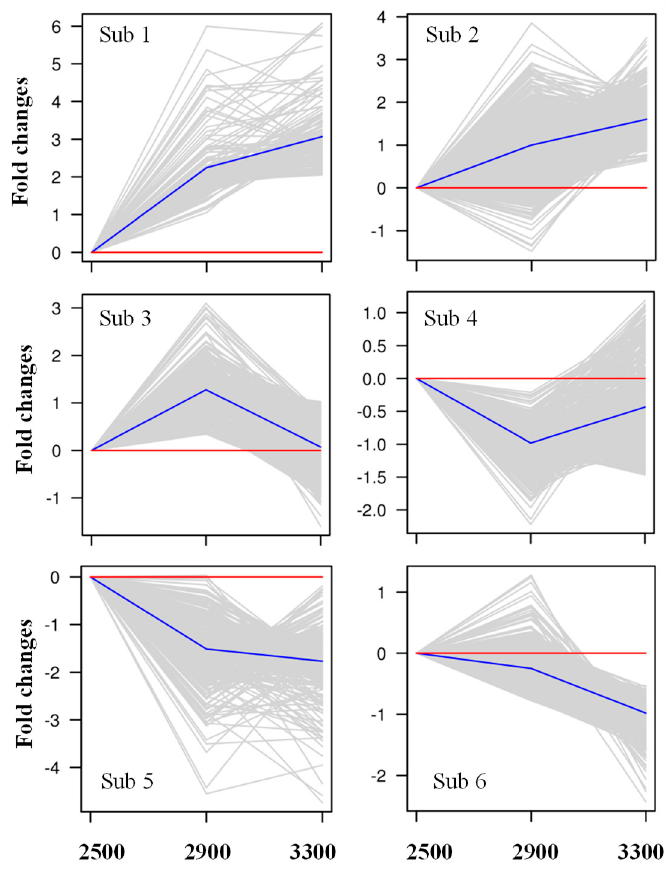
Figure 8. Clustering analysis by K -means clustering of differentially expressed genes (DEGs) in Picea crassifolia with elevations.